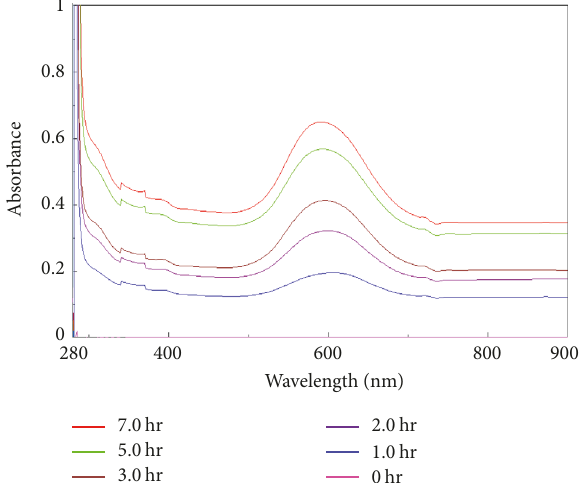
Figure8: Effectsofthemembraneporesizeon transdermaldelivery of 1.2% potassium ferricyanide.